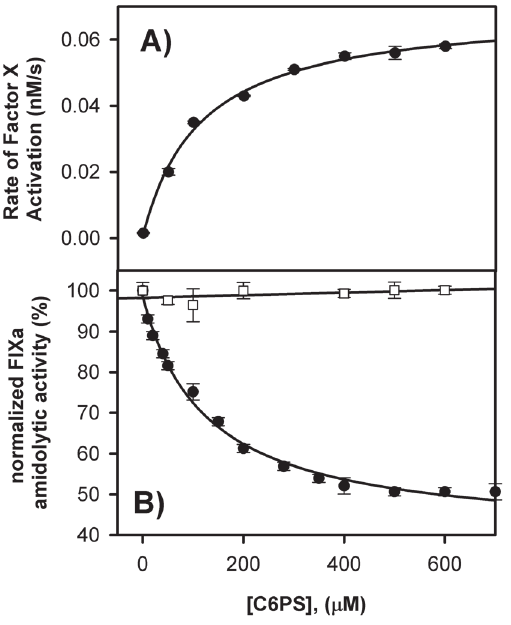
Figure 3. Variation of (A) Proteolytic and (B) Amidolytic Activities of FIXa Due to Addition of C6PS. A: Proteolytic activation of 200 nM FX by 5 nM FIXa in 50 mM Tris, 150 mM NaCl, 5 mM Ca 2 + and 0.6%PEG, pH-7.5 at 37 u C was monitored at different concentrations of C6PS, with a fit of the data to a single site (hyperbolic) model shown and yielding an apparent Kd of 115 6 10 m M B: Amidolytic activity of 300 nM FIXa in a buffer containing 50 mM Tris, 150 mM NaCl, 5 mM Ca 2 + and 0.6% polyethylene glycol was assayed using 1 mM synthetic substrate Pefa-3960 and increasing concentrations of C6PS, with a fit of the data to a single-site (hyperbolic) model, as shown, yielding an apparent K d of 130 6 10 m M. The curve with open squares represents the amidolytic activity of FIXa in the absence of Ca 2 + and with 1 mM EDTA.